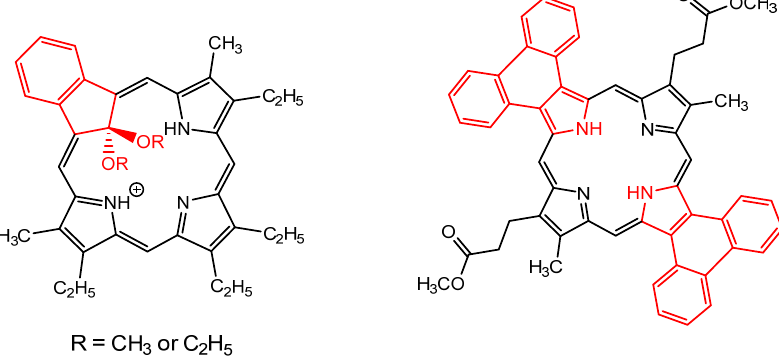
Figure 6. Molecular structures of some porphyrin derivatives tested against Leishmania parasitic disease, by Lash et al. [110,111].